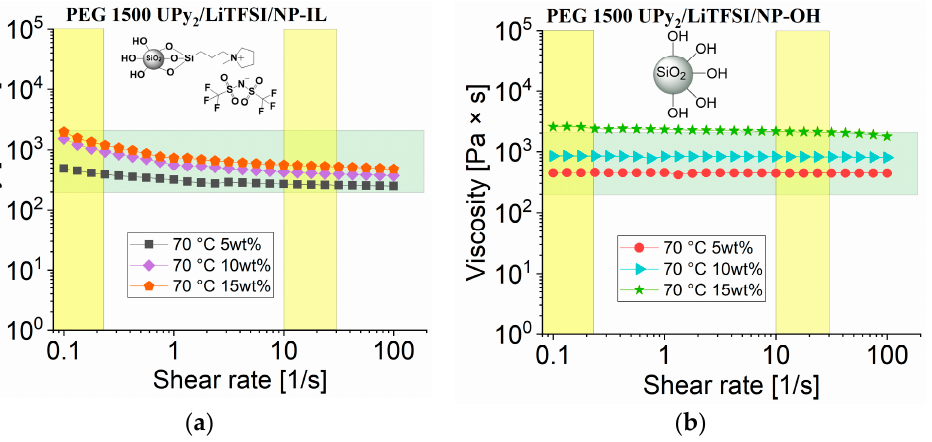
Figure 8. Rheology measurement of viscosity vs. shear rate for ( a ) PEG 1500 UPy 2 /LiTFSI mixed with NP − IL (5% ( 2 ), 10% ( 3 ), 15% ( 4 )) at 70 °C; ( b ) PEG 1500 UPy 2 /LiTFSI mixed with NP − OH (5% ( 5 ), 10% ( 6 ), 15% ( 7 )) at 70 °C.